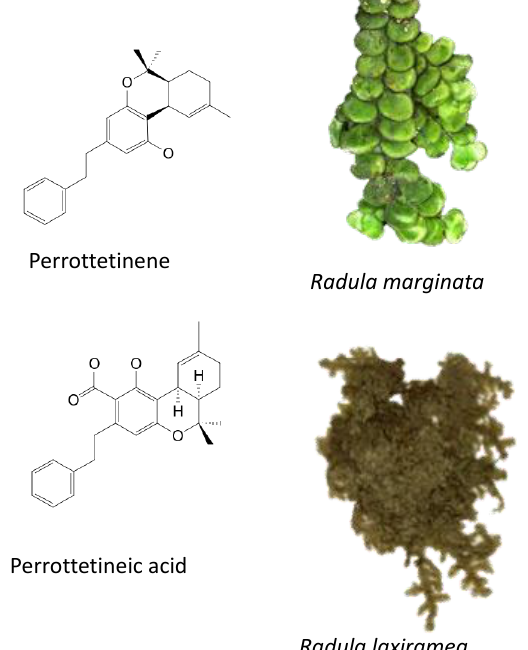
Figure 3. Phytocannabinoids in Radula marginata and R. Laxiramea .